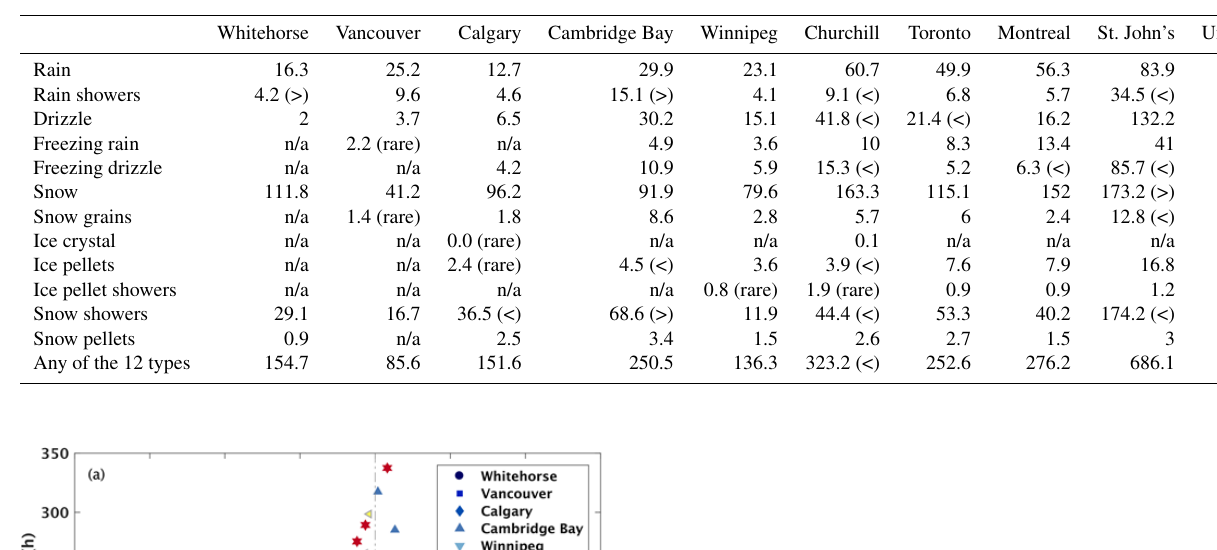
Table 3. The average number of hours with the 12 different precipitation type occurrences, and the indication of the direction of changes over the 1981–2011 period (in parentheses): the absence of parentheses denotes no significant change; “>” indicates a statistically significant increasing change; “<” indicates a statistically significant decreasing change; “rare” indicates that the given precipitation type rarely occurs and that the change is not computed; and “n/a” indicates that there were not enough data to compute the change. The statistical significance of the trends was assessed at the 5% level.